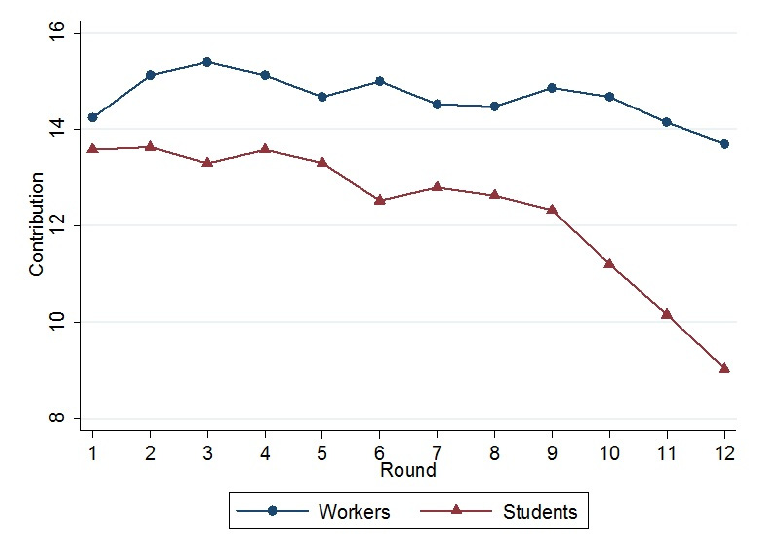
Figure 3. Evolution of average contributions over time (students vs.